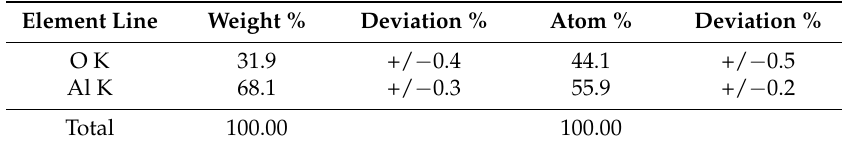
Table 5. Chemical composition of oxide layer.